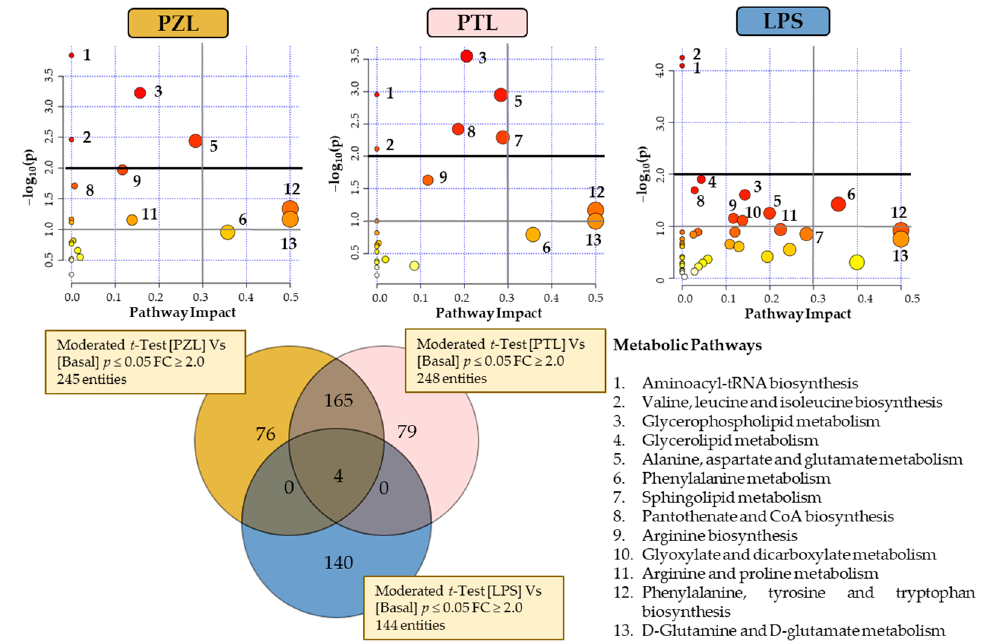
Figure 4. Venn diagram and metabolome overviews obtained from MetaboAnalyst pathway analysis of the subsequent evaluated conditions: PZL, phlorizin + LPS; PTL, phloretin + LPS; and LPS compared to BASAL. The top-pathways are ranked by the gamma-adjusted p values for permutation per pathway (y-axis) and the total number of hits per pathway (x-axis). The colour graduated from white to yellow, orange and red, circle size (large > small) as well as the values of both x and y increase represents the degree of significance.